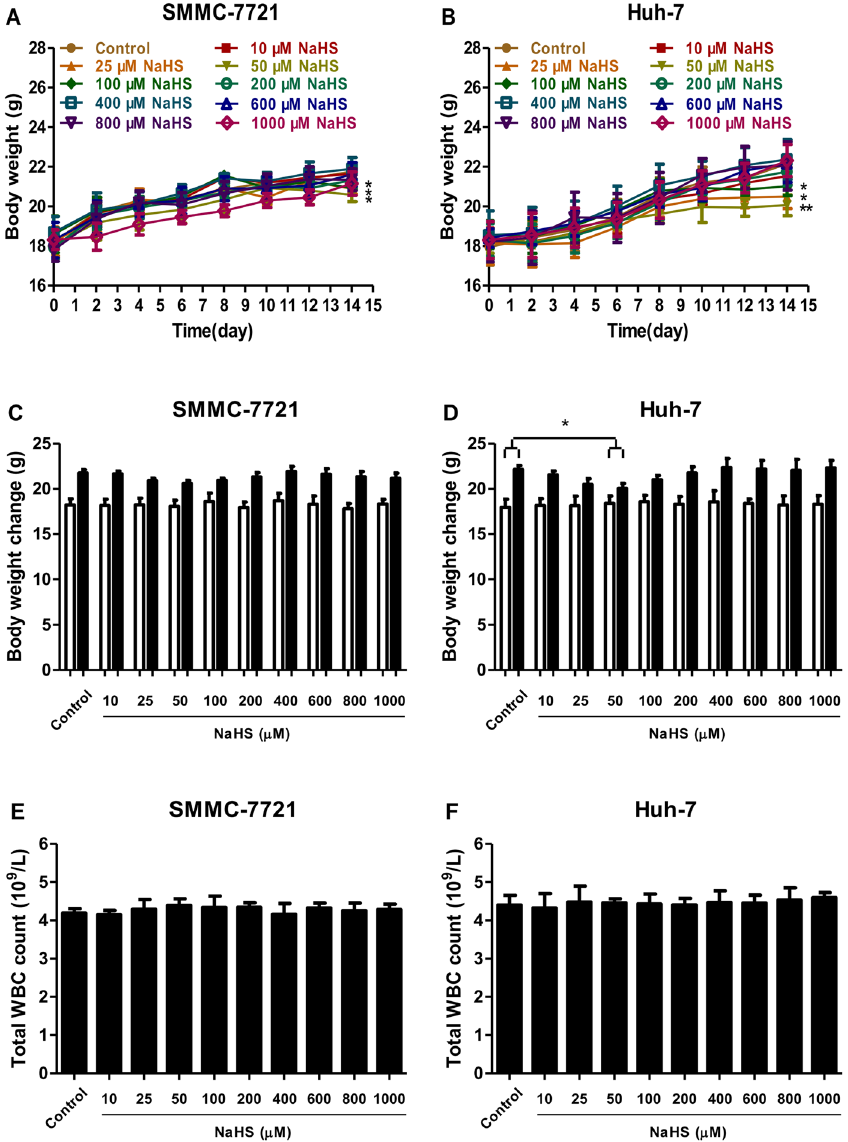
Figure 9. Body weight change and total WBC count of BALB/c nude mice after subcutaneous administration of NaHS at the indicated concentrations for 14 days. ( A and B ) The body weight change curve of each group during the experiment. ( C and D ) The body weight of each group on the first day (day 0) and the last day (day 14). ( E and F ) The total WBC count of each group was examined at the end of the experiment. Values are presented as mean ± SEM (n = 6); * P < 0.05, ** P < 0.01 compared with the control